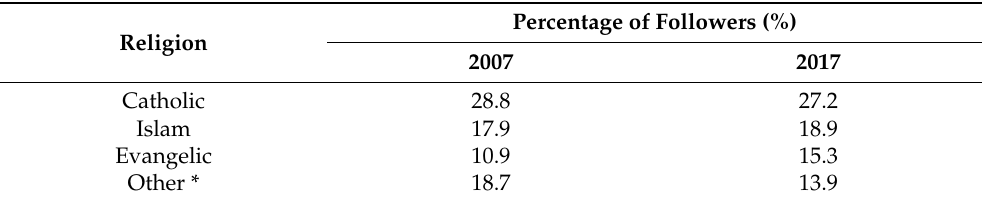
Table 1. Percentage of followers of different religions in Mozambique in 2007 and 2017. Source: Adapted from Mutiua